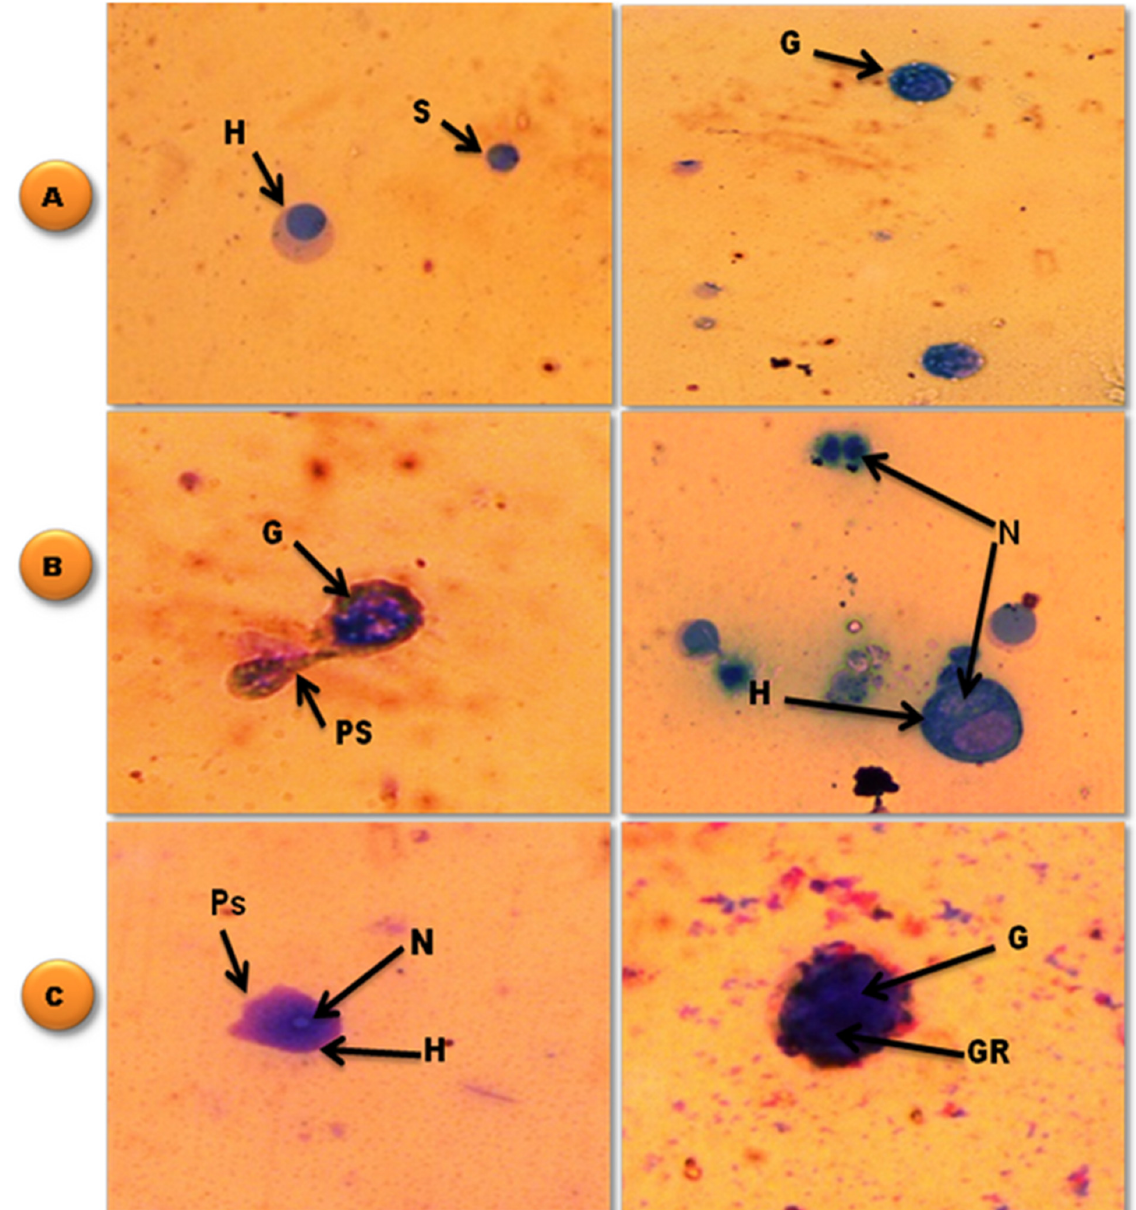
Figure 8. Photomicrographs (×40) of different types of hemocytes.( A ) hemocytes of control group of adult B. alexandrina snails, ( B ) B. alexandrina snails hemocytes after exposure to LC 10 of SeNPs (31.826 mg/L), ( C ) hemocytes of adult B. alexandrina snails after exposure to LC 25 of SeNPs (44.15 mg/L). Abbreviations, G: granulocyte, GR: granules, H: hyalinocyte, N: nucleus, PS: pseudopodia, S: small round.